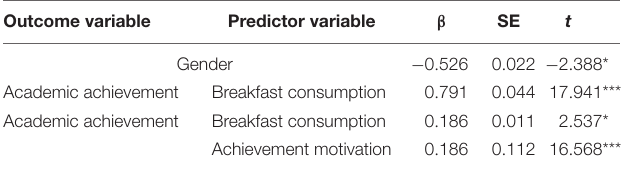
TABLE 2 | The Mediation Model Test of achievement motivation.